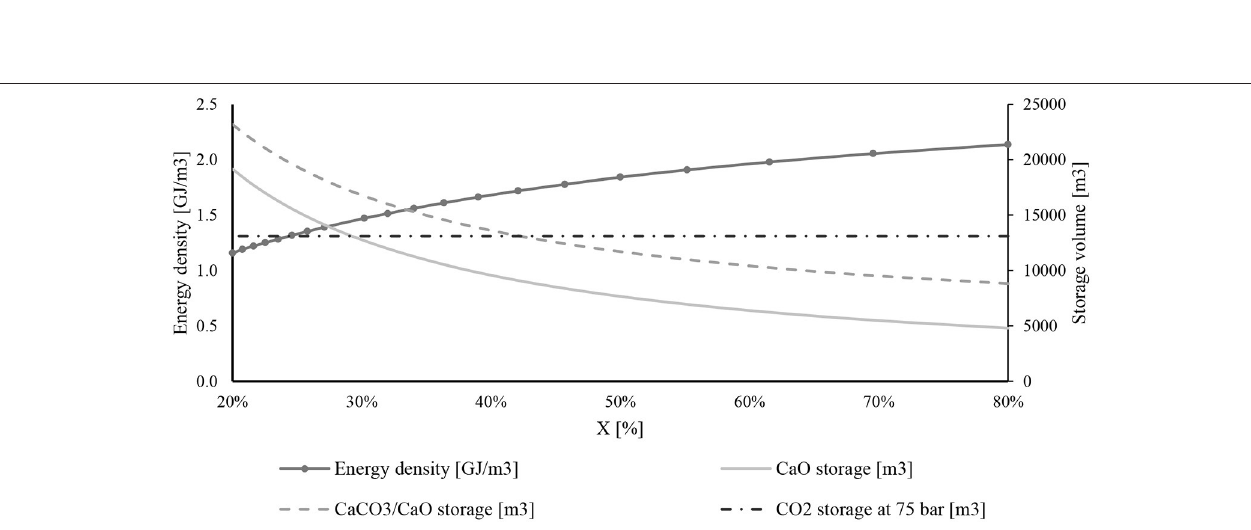
Frontiers in Sustainability |